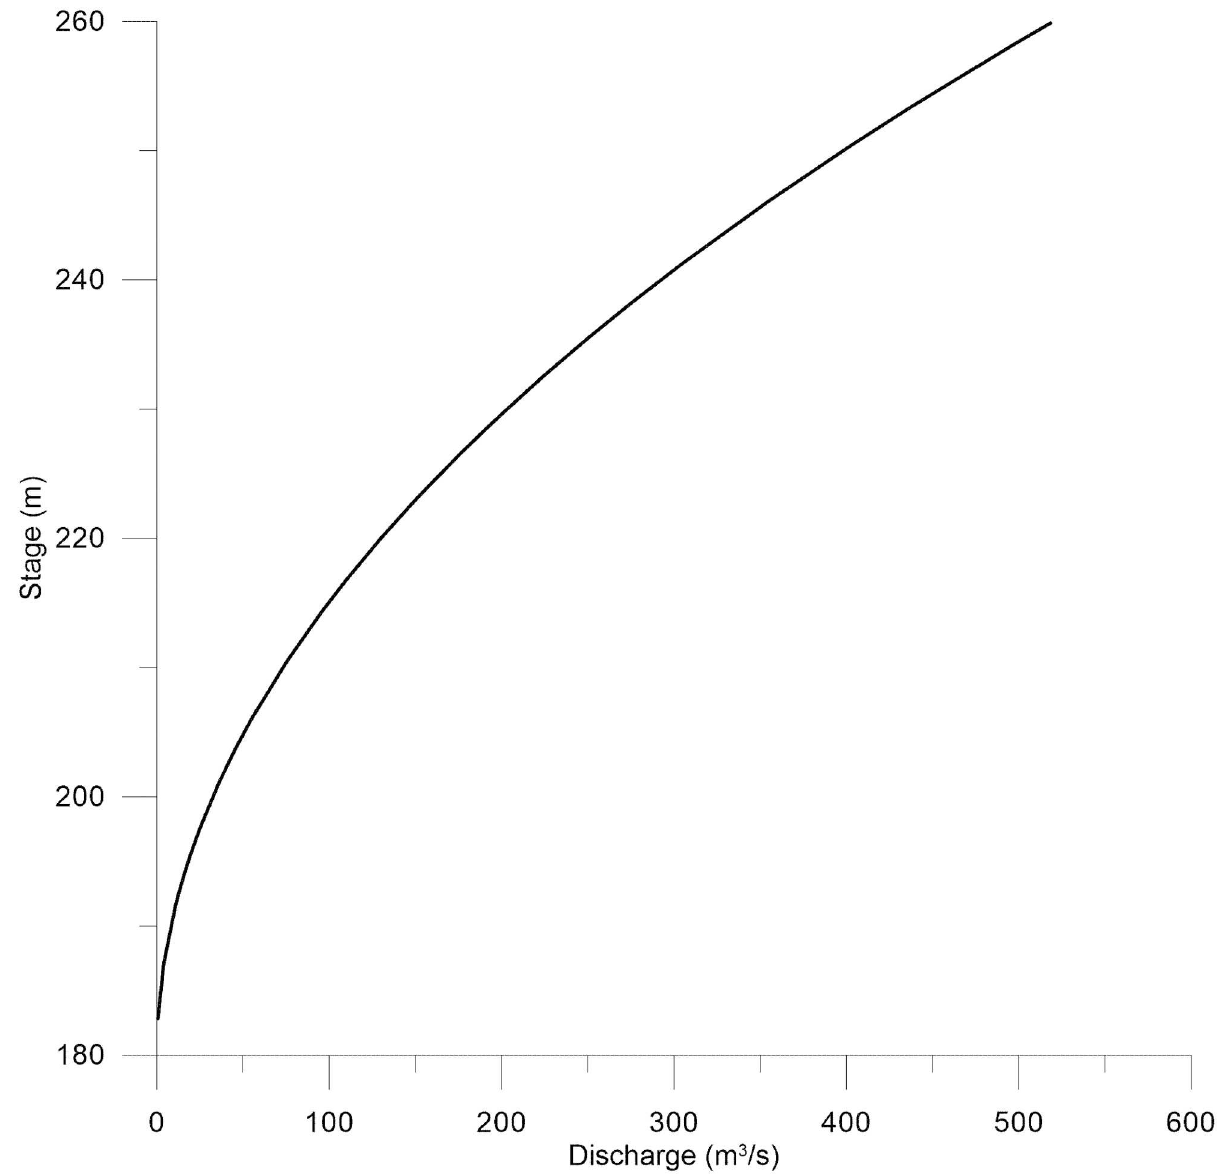
Fig 3. The stage–discharge curve used as a boundary condition in quasi-unsteady flow data in